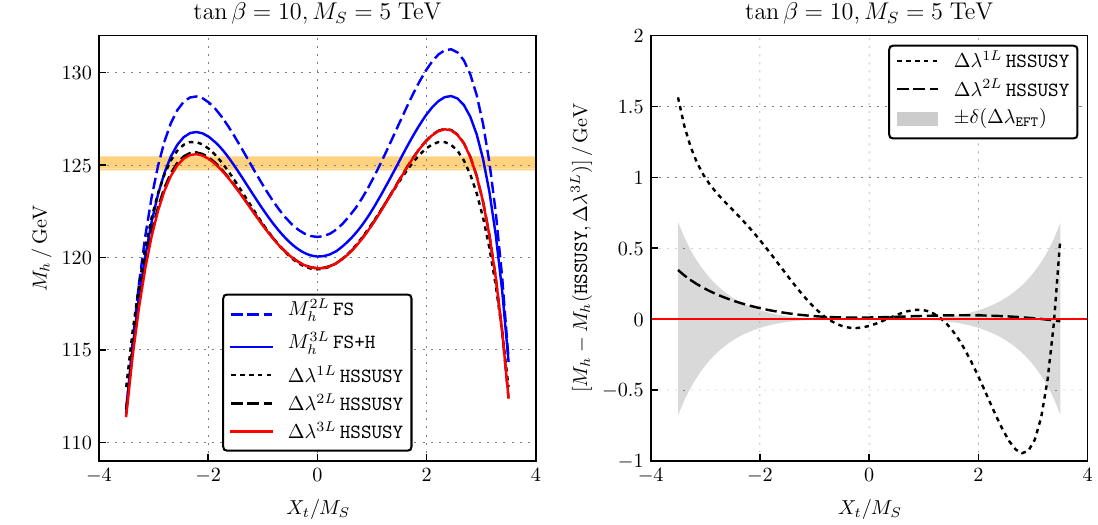
Fig. 2 Comparison of the three-loop HSSUSY (EFT) calculation with lower order EFT and fixed-order MSSM calculations from the FlexibleSUSY package as a function of the relative stop mixing